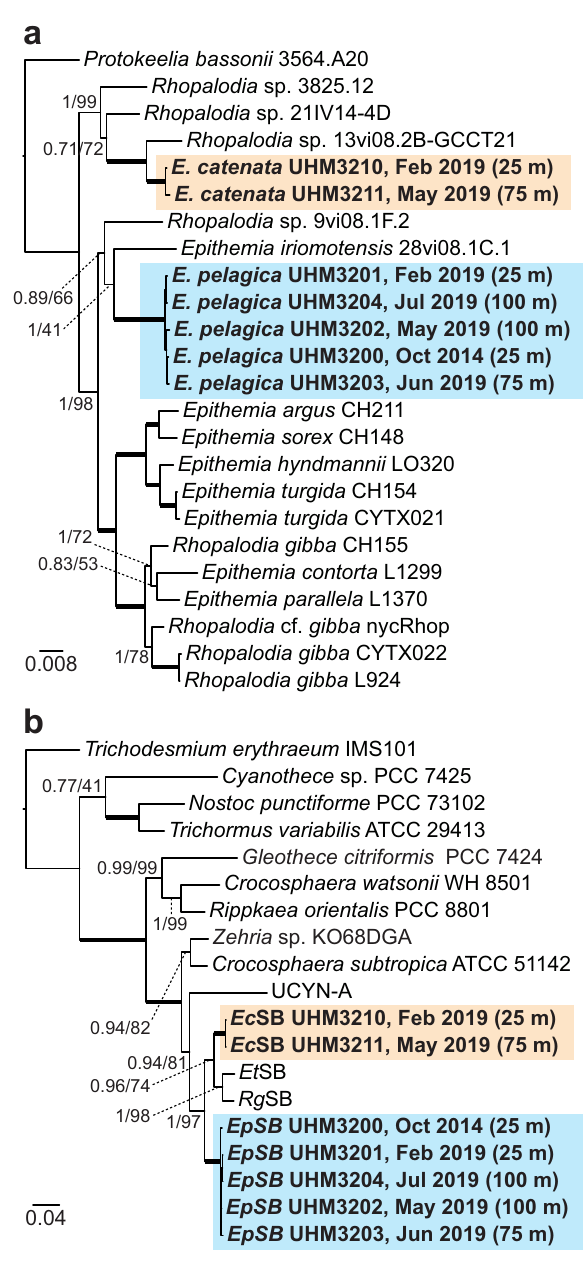
Fig. 2 Phylogenetic analyses. a Multigene phylogeny of the E. pelagica and E. catenata diatom hosts, based on the SSU (18S rRNA; 1322 nt), psbC (986 nt), and rbcL (1341 nt) genes. b Multigene phylogeny of the Epithemia endosymbionts, based on the SSU (16S rRNA; 420 nt) and nifH (760 nt)